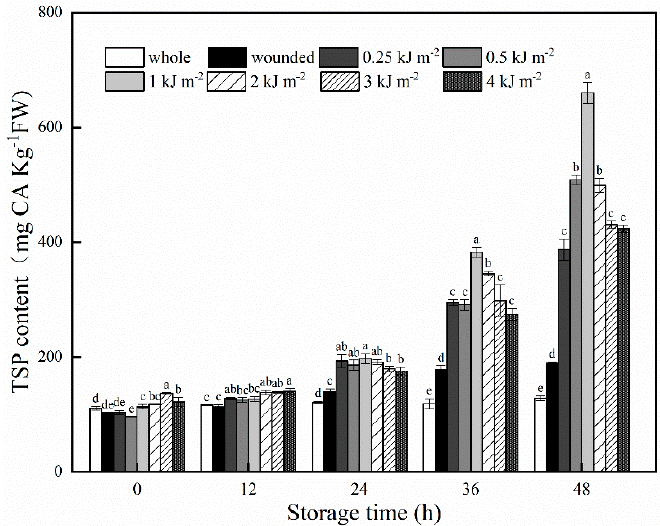
Figure 1. TSP contents of whole, wounded and UV-B–treated carrots stored at 15 ◦ C for 48 h. Data are expressed as the mean ± standard deviations of triplicate values. Lowercase letters represent significant difference ( p < 0.05) among treatment factors at the same sampling time.